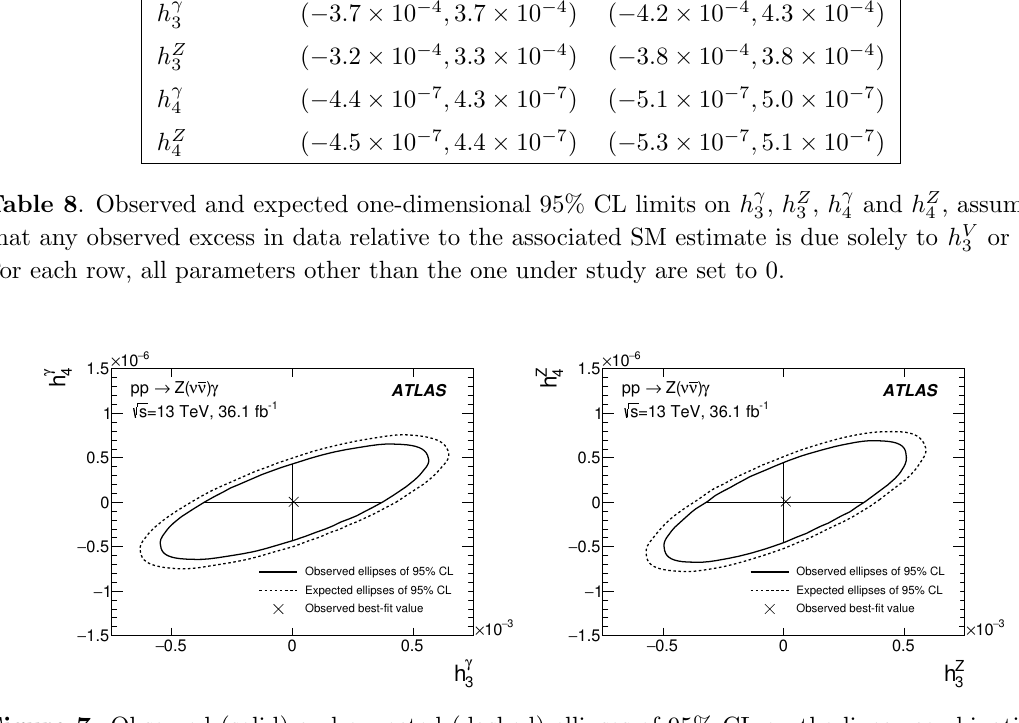
and h (cid:13) (left) and h Z and h Z (right). The horizontal and 3 4 3 4